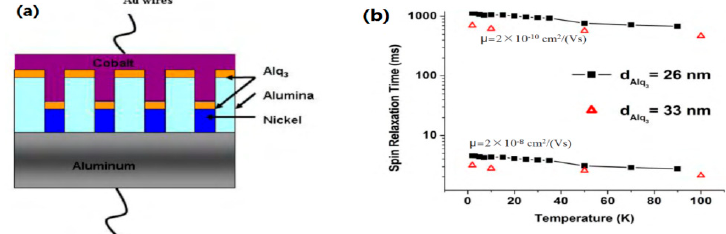
Figure 9. ( a ) A schematic diagram of nanowire spin-valve structure consisting of Co/Alq 3 /Ni. ( b ) The calculated spin diffusion time τ as a function of temperature at different carrier mobility µ . Adapted from [34], with permission from © 2007 Springer